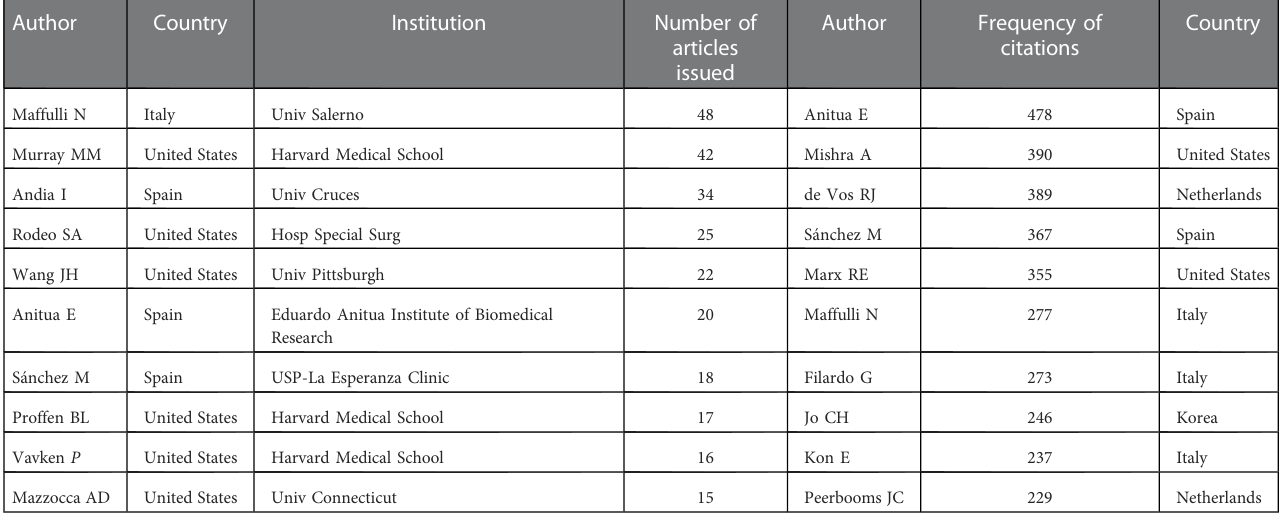
TABLE 2 Top 10 high-impact authors of platelet-rich plasma studies for tendon and ligament